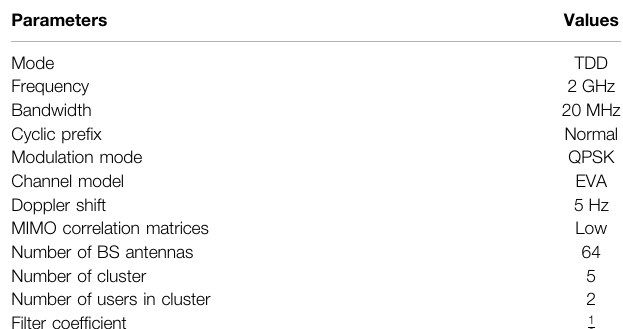
TABLE 1 | Parameters of communication